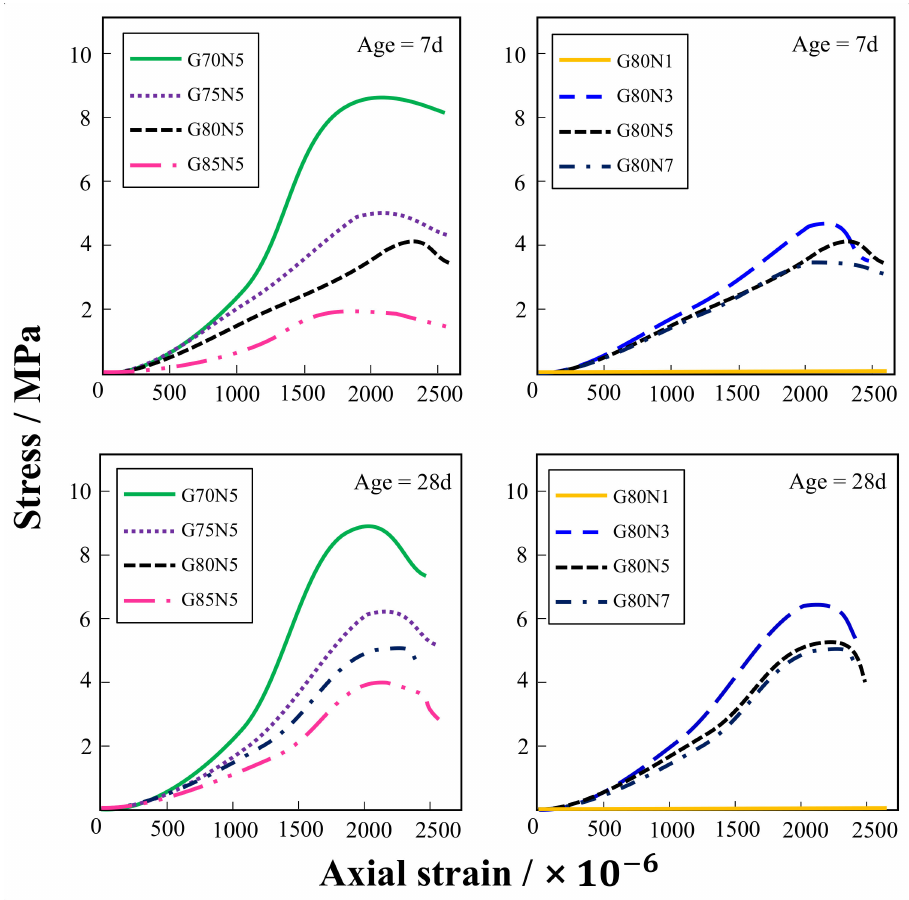
Figure 2. Stress–strain curve of coal gangue road stabilization material at different